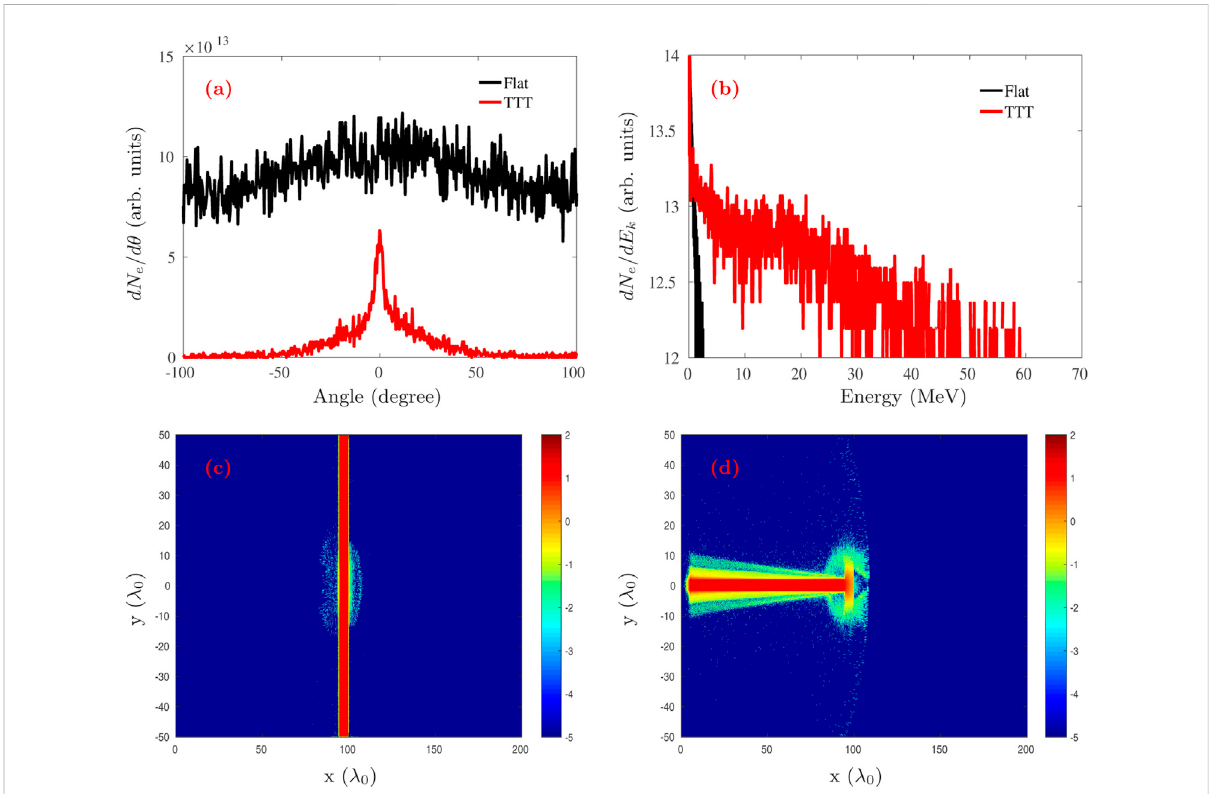
FIGURE 5 The angular distribution (A) , energy spectrum distribution (B) and the spatial distributions (C) , (D) of the electrons passing through the interface behind the target at time t = 110 T 0 for both of the fl at target and TTT.